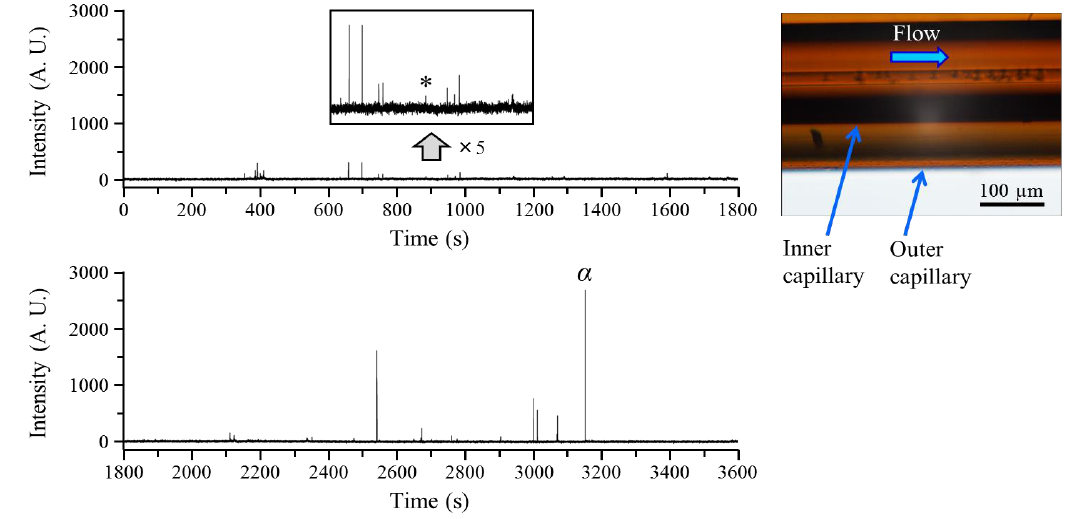
Figure 3. Time profile for toluene in an O/W emulsion with white turbidity. The time profile was obtained by extracting the peak areas at m / z 92 and 91 (see text). It is noted that the bottom time profile is a continuation of the top time profile. The bright-field image of a sample flowing through an inner capillary column is also shown. The most intense spike is specified by α , and was used for obtaining S max (see text). A peak with an S / B of 3 is marked with an asterisk (*).